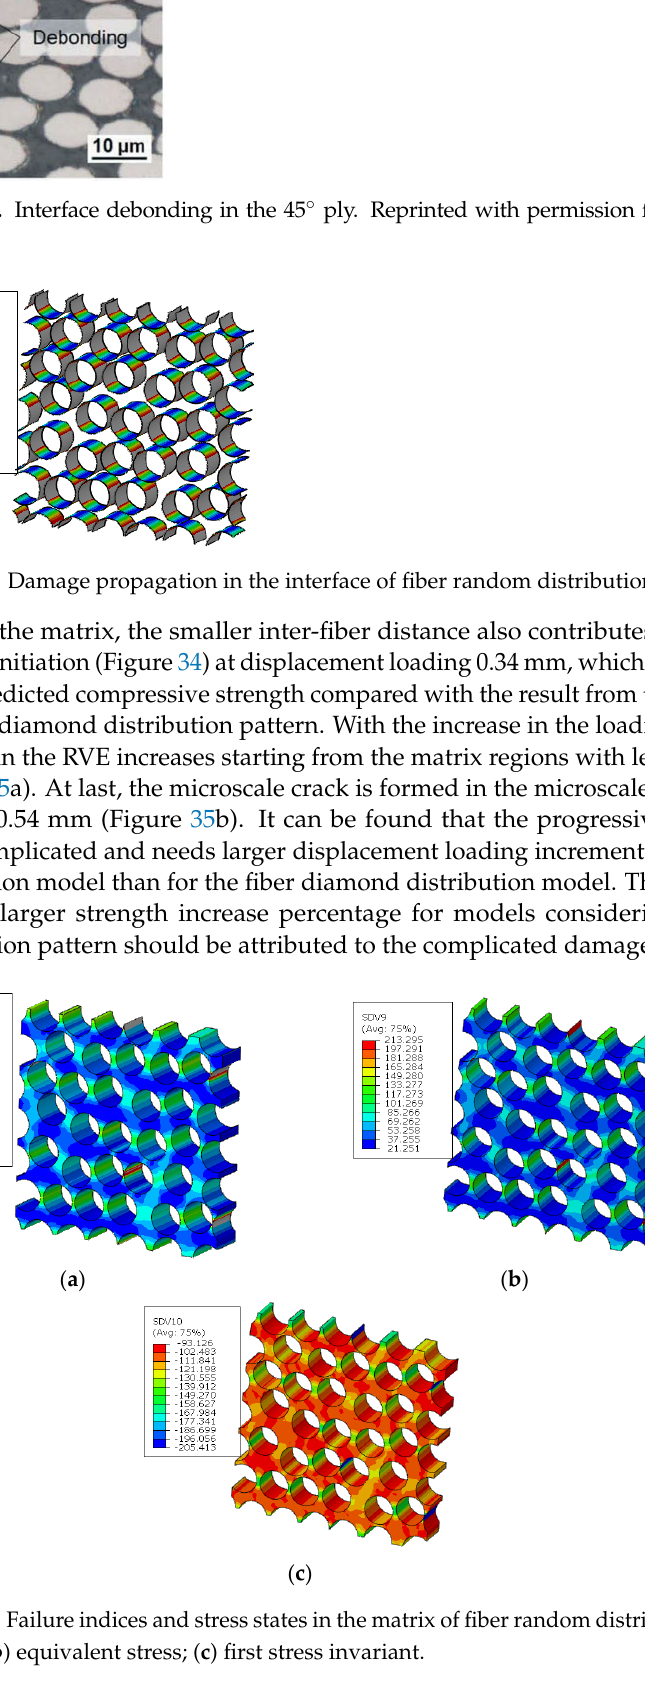
( b ) Figure 35. Matrix damage propagation in the matrix of fiber random distribution model. ( a ) at displacement loading 0.4 mm; ( b ) at displacement loading 0.54 mm. The failure indices and stress patterns for the fiber breakage initiation are shown in Figure 36. It can be found that the damage is induced by the compressive stress and the fibers fail at almost the same time, which is the same as the conclusion obtained in the model considering the fiber diamond distribution pattern.